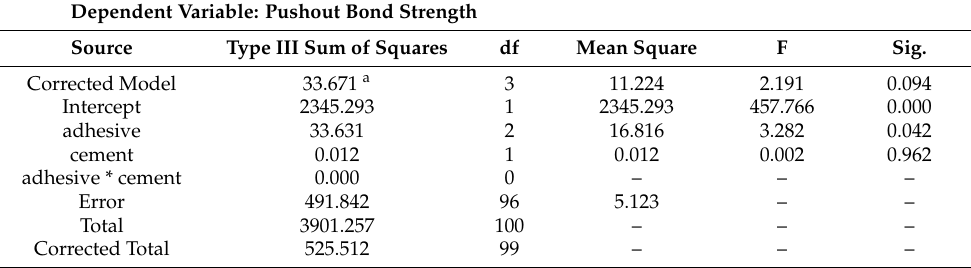
Table 3. Results of the two ANOVA analysis.